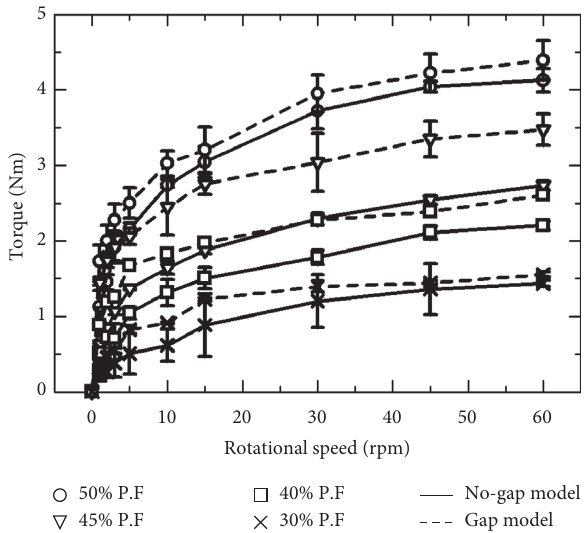
Figure 12: The torque versus diameter of the particle curve of the rotary damper with gap and no-gap models at 60rpm.